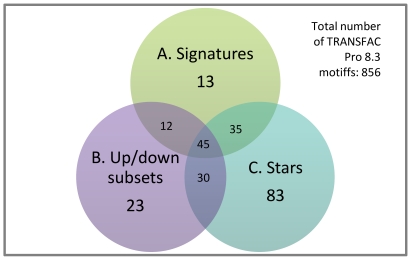
Number of motifs found in common between the different analytical approaches.Number of motifs occurring in the A. signature profiles, B. up/down regulated signature subset profiles, and C. cluster profiles.